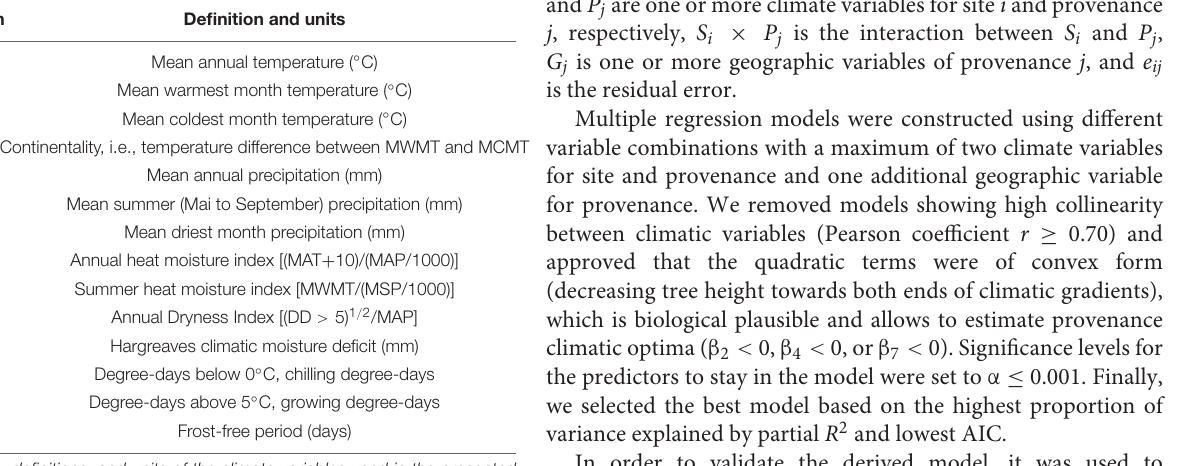
TABLE 1 | Climate variables used for model